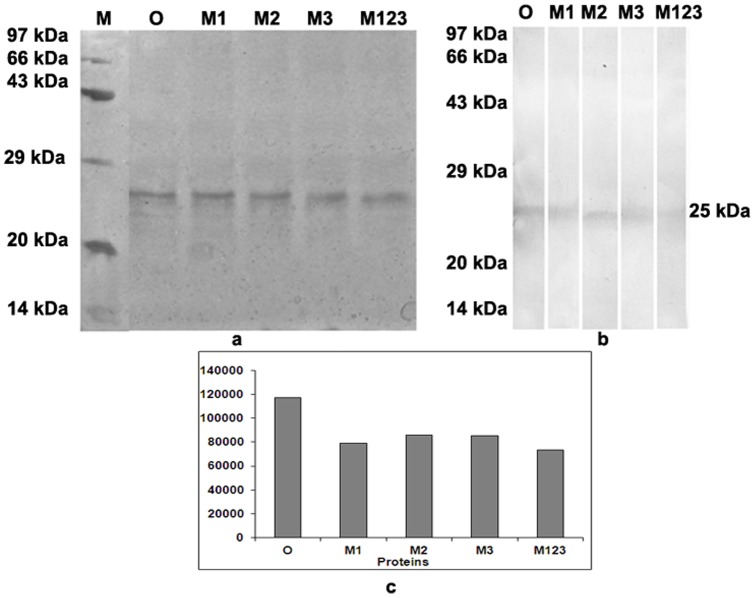
SDS-PAGE profile of purified osmotin and the three mutants.(a) The proteins were resolved on 12% gel and stained with Coomassie brilliant blue. (b) SDS-PAGE resolved protein was transferred on to nitrocellulose membrane and probed with osmotin positive patients' pooled sera. Lane M was loaded with Molecular weight marker. Lanes O, M1, M2, M3, M123 were loaded with osmotin and the mutants respectively. (c) Graph showing densitometric scan of spots of the blot.